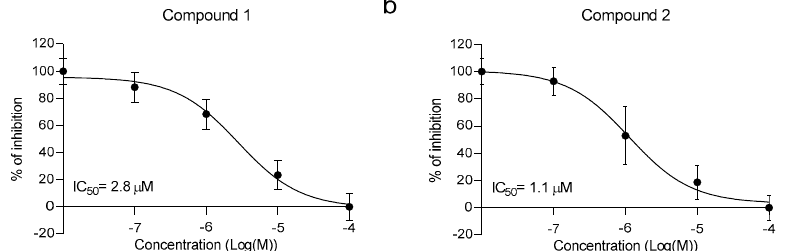
Figure 3. cAMP variation in cells co-expressing rho-TAAR5 and BRET EPAC biosensor. Cells were treated with the compounds at different concentrations and plotted as dose–response experiments. Non-linear regression with one site-specific binding is used to draw the curve using GraphPad Prism9. The data are plotted as a percentage of inhibition ± SEM of 3 independent experiments for compounds 1 ( a ) and 2 ( b ).